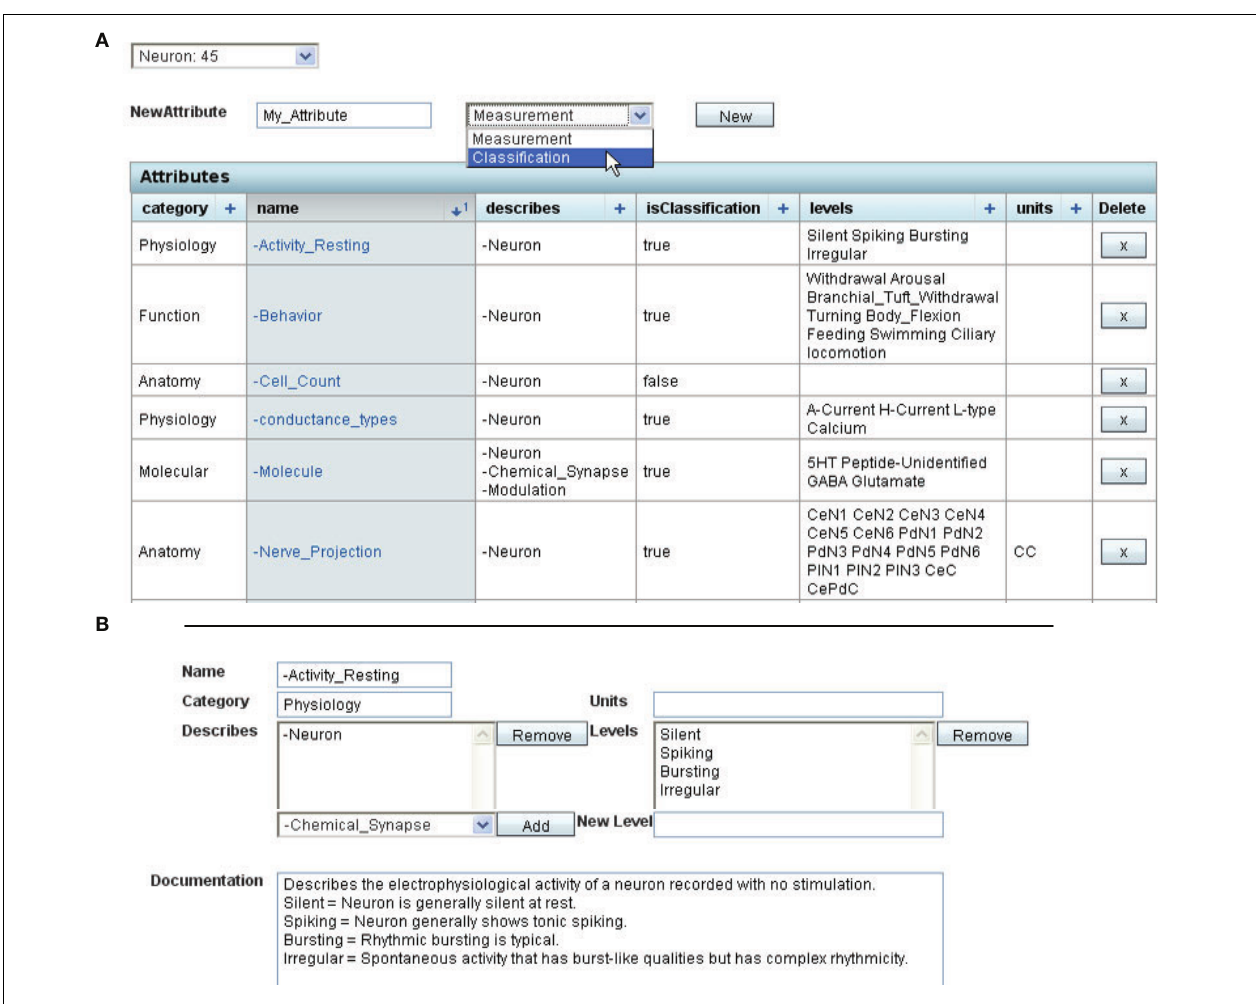
FIGURE 3 | Screenshot showing editing of extensible attributes in the web client. (A) . The list of extensible attributes for a neuron is editable. This screenshot shows the fi rst 6 attributes of Neurons in the Tritonia extensible list. A new attribute can be added by fi lling in the name (here “My_Attribute”) and choosing whether the attribute is a Measurement or